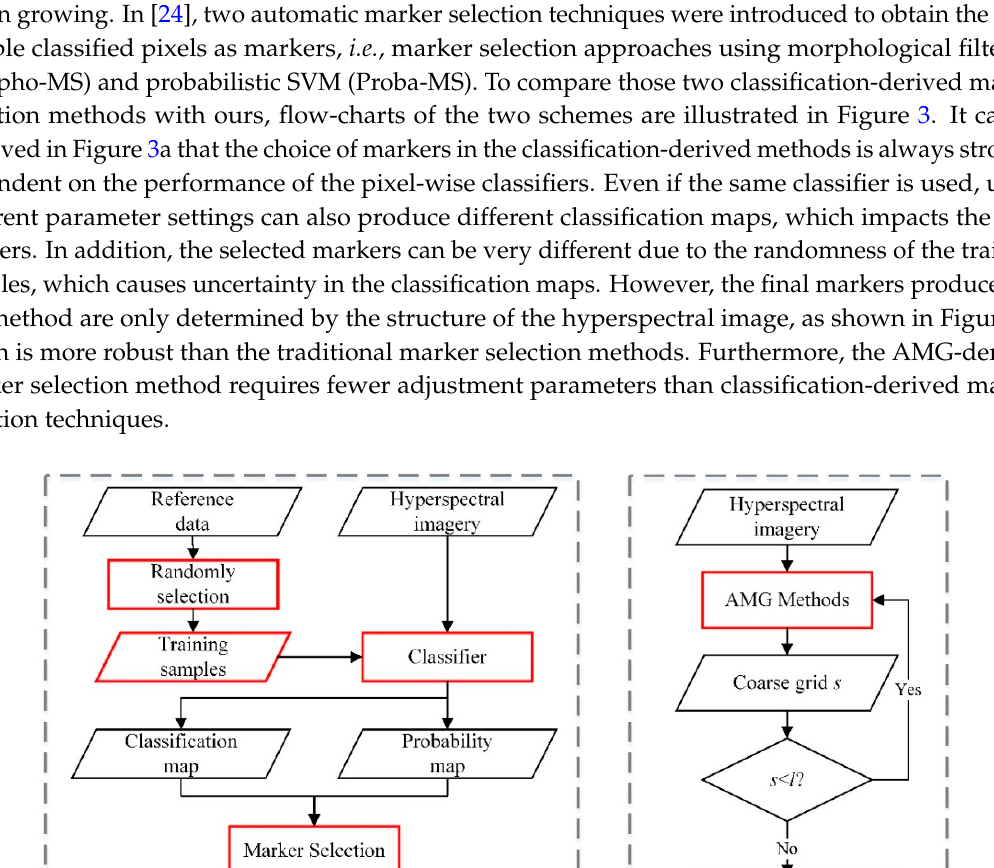
Algorithm 1: AMG-derived M-HSEG Segmentation Algorithm